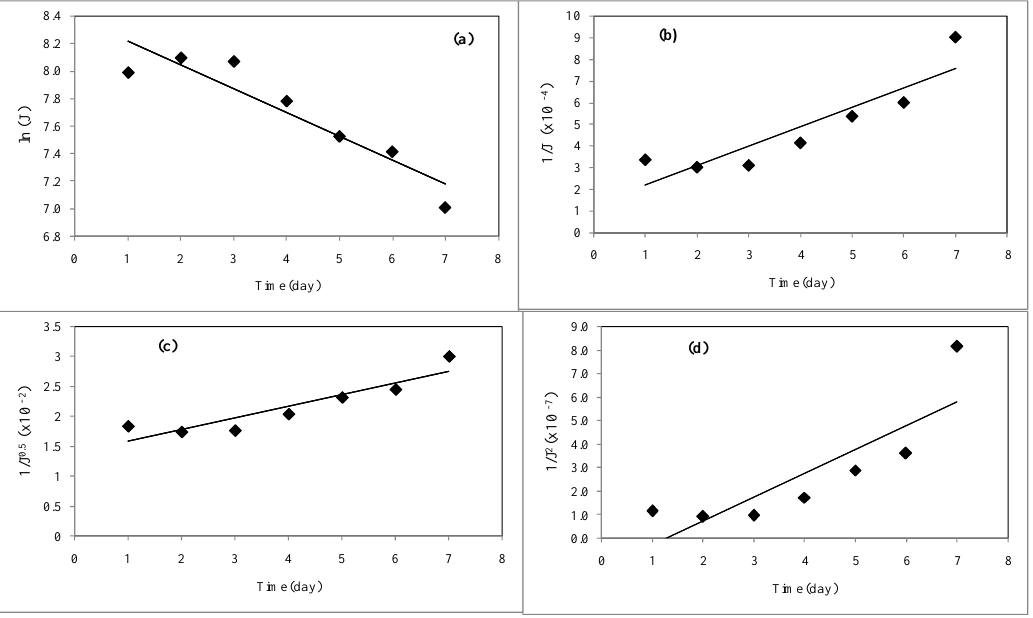
Figure 6. Linear plot of flux vs. time for different pore blocking models at 4.5 kPa: ( a ) complete pore blocking model (ln( J ) vs. t ) as given in (Equation(2)); ( b ) intermediate pore blocking model (1/ J vs. t ) as given in (Equation (4)); ( c ) standard pore blocking model (1/ J 0.5 vs. t ) as given in (Equation (6)), and ( d ) cake layer formation model (1/ J 2 vs. t ) as given in (Equation (8)).